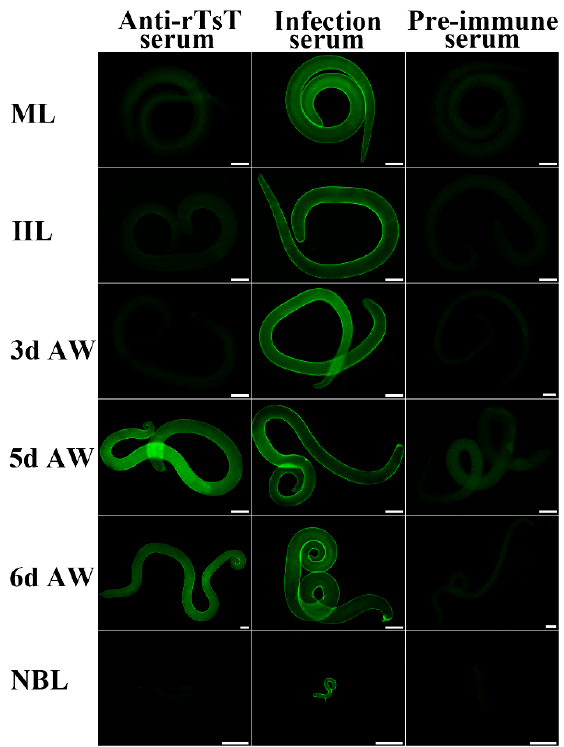
Figure 7. Expression and localization of TsT at the cuticle of diverse T. spiralis worm stages by IIFT.